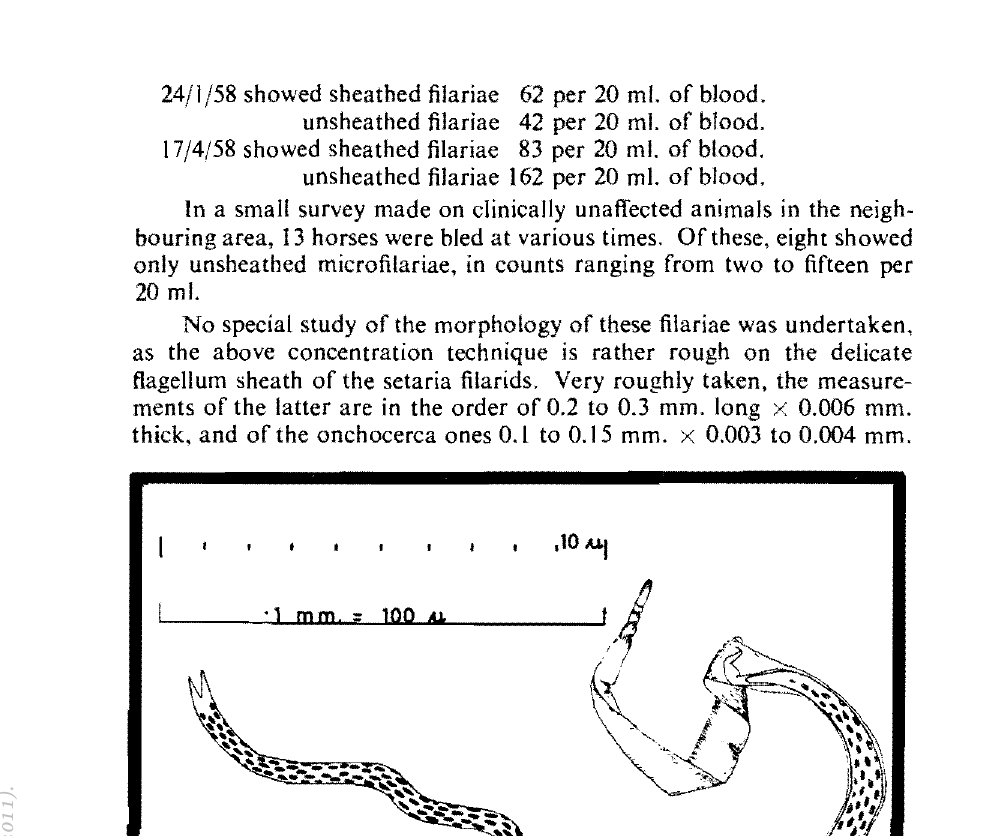
FIG. 3-Types of Microfilaria sheathed on right unsheathed on left.